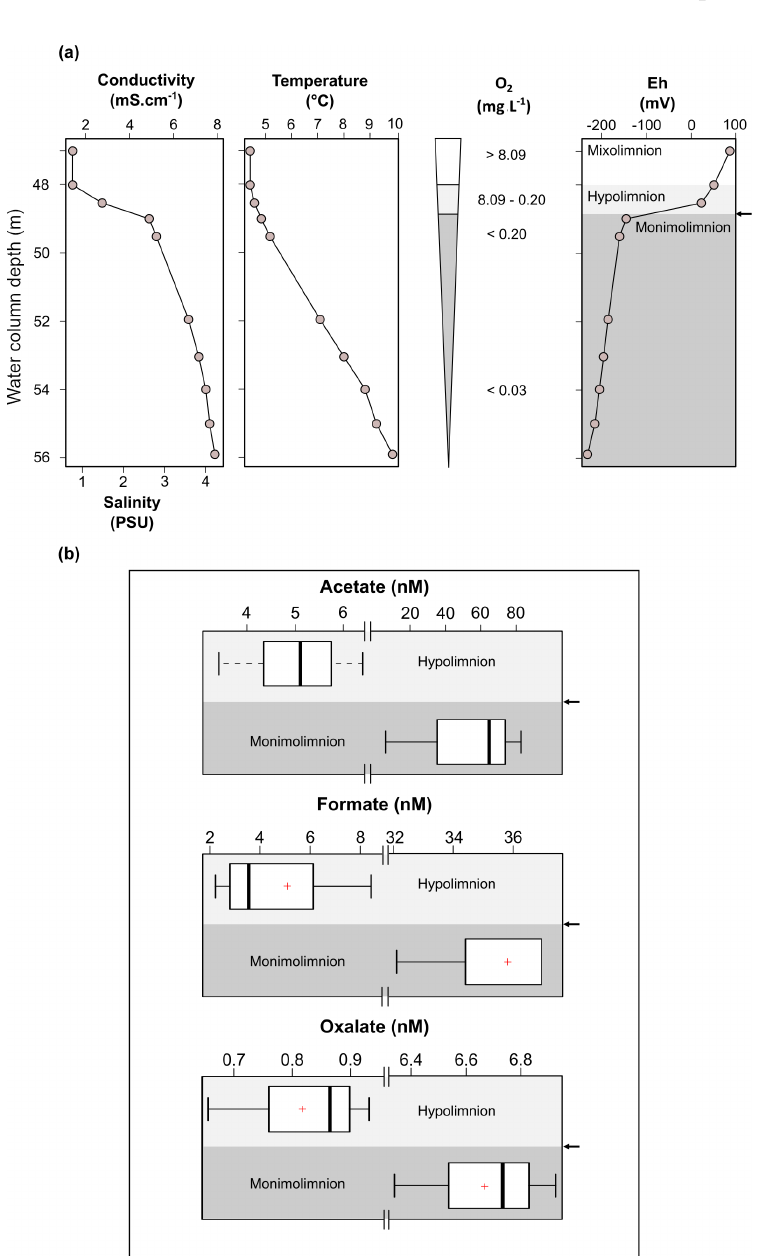
Figure 2. Physicochemical parameters in the dysoxic to anoxic waters of Lake Medard in its central sampling location, which has a maximum depth of 56m (a) , and concentration range of acetate, formate and oxalate quantified in the dysoxic ( n = 4; < 48 depth) and anoxic ( n = 3; 54–55m depth) waters of Lake Medard (b) . The arrow shows the